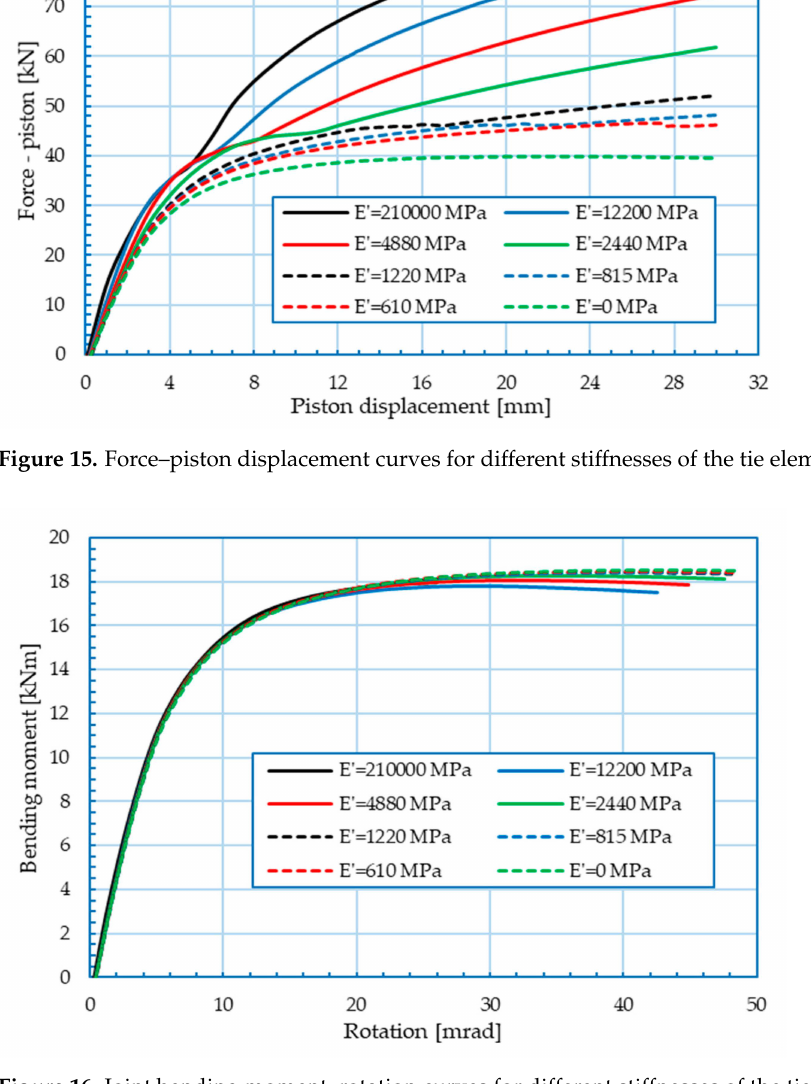
Figure 16. Joint bending moment–rotation curves for different stiffnesses of the tie